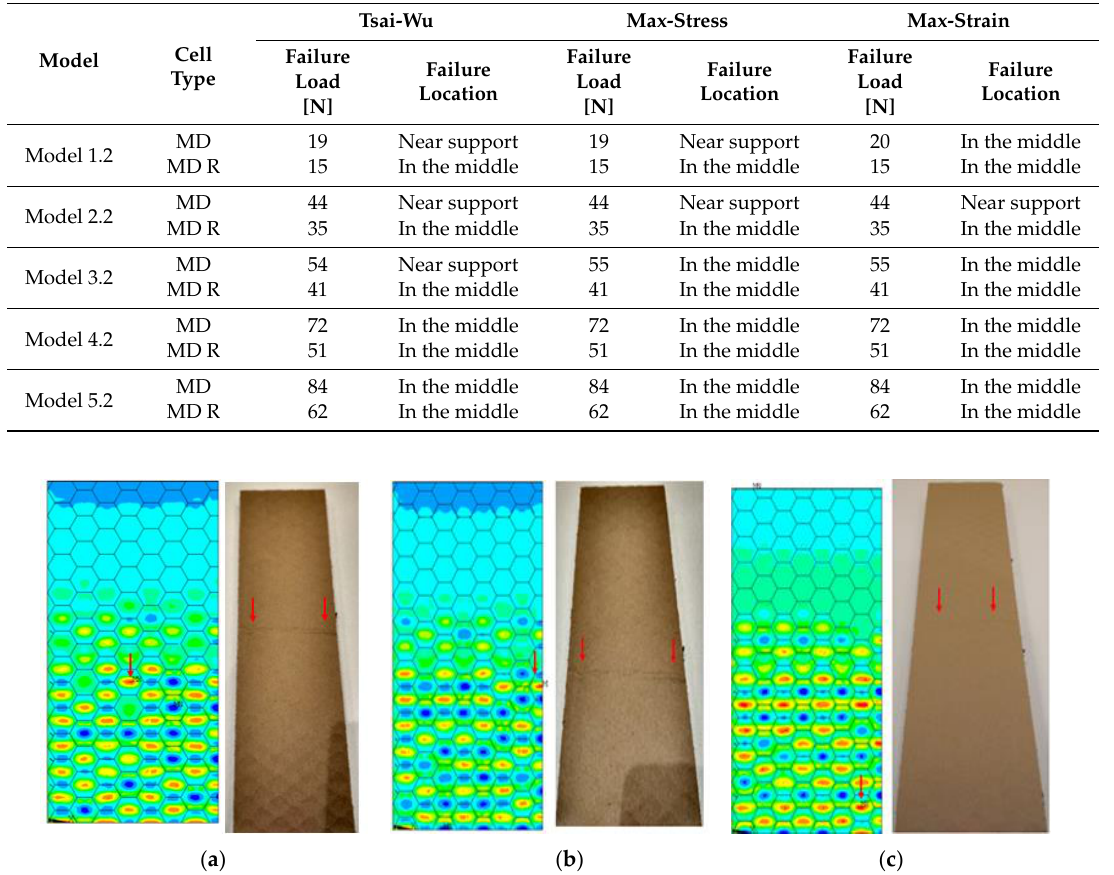
Table 5. Comparison of failure loads and locations for models in MD.